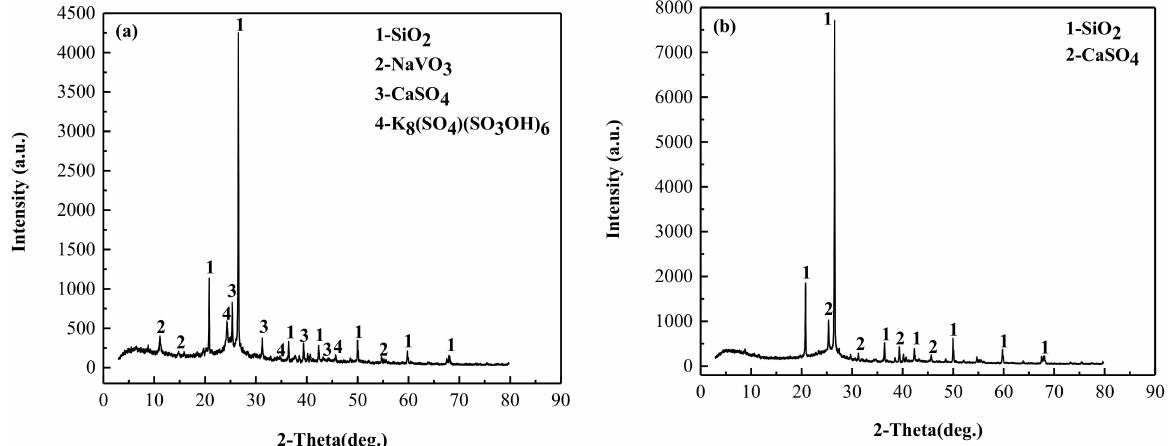
Figure 5. XRD diffractogram of ( a ) roasted ore and ( b ) leaching residue.